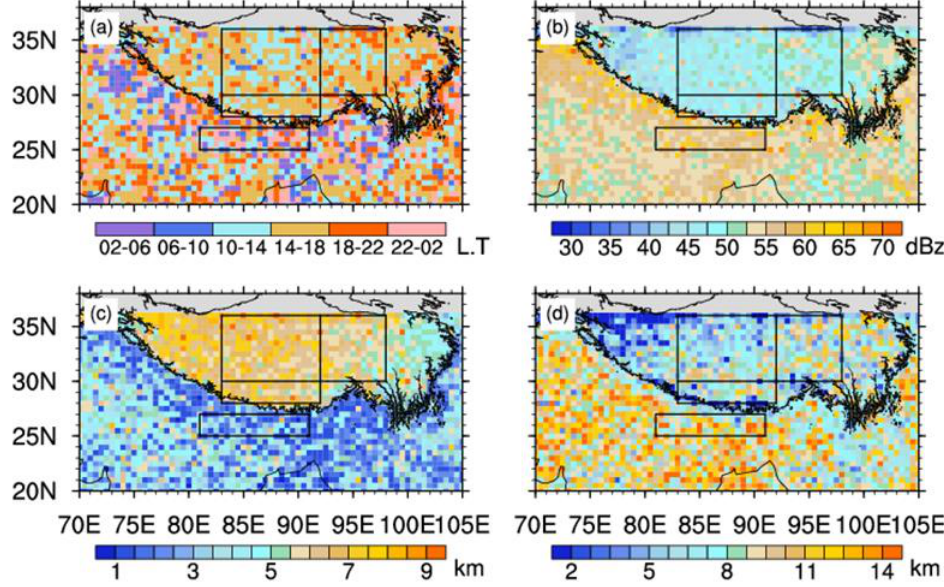
Figure 6. The spatial distribution of time peak of ( a ) the maximum echo, ( b ) the maximum echo and ( c ) its altitude, and ( d ) the height difference between the altitude of echo top and the altitude of the maximum echo for DCP in summer over the QTP and its southern regions calculated from observations of TRMM PR from 1998 to 2012. The black boxes marked in each panel are seen in Figure 1. The spatial distribution of the height difference between the echo top altitude and the altitude of DCP maximum echo shows that such difference is less than 8 km in the